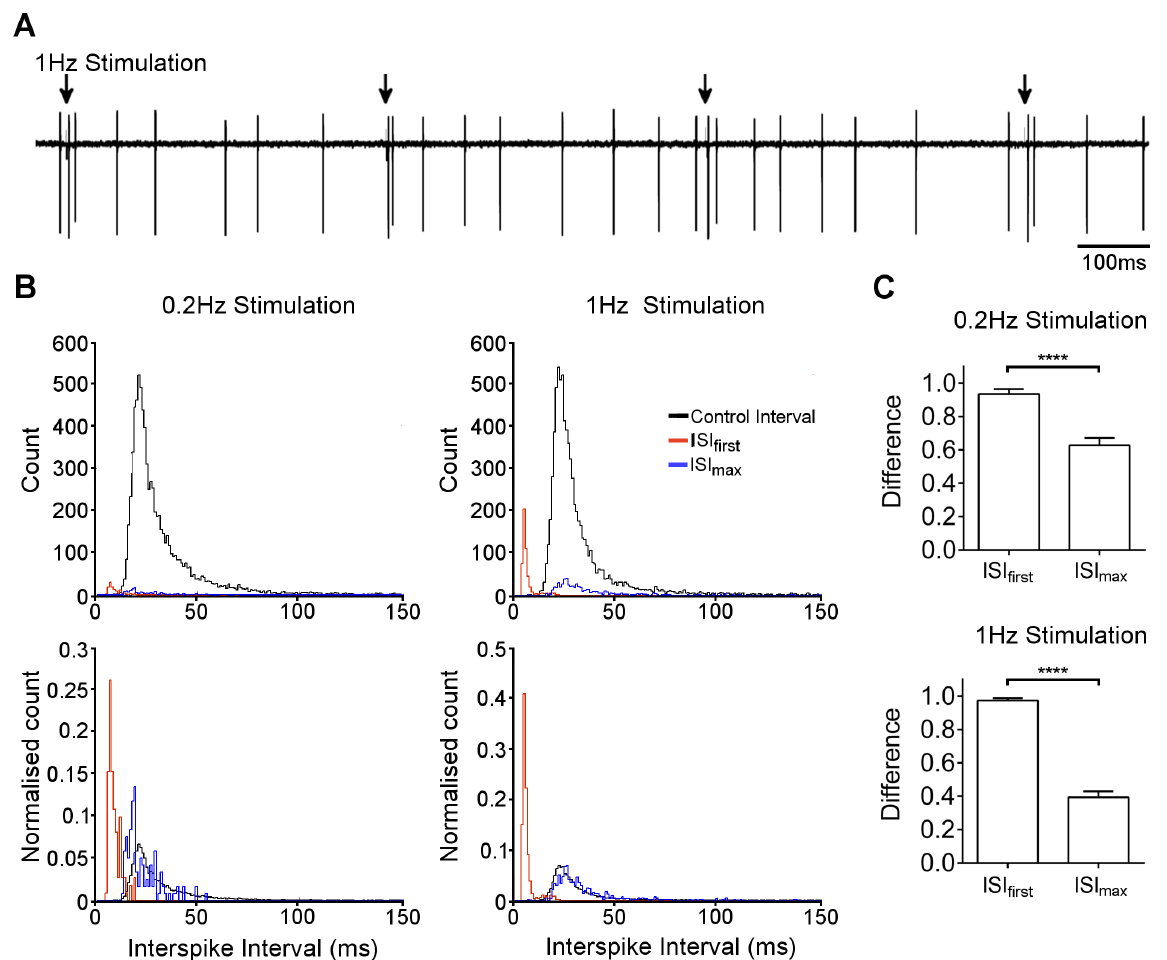
Figure 7. Distribution of post-stimulus intervals. A) Loose cell attached recording during regular stimulation at 1 Hz (arrow). B) Distribution of first post-stimulus interval (ISI first , red line), maximum post-stimulus interval (ISI max , blue line) and intervals uncorrelated with stimulus (black line). Left panels show representative cell stimulated at 0.2 Hz, right panels show representative cell stimulated at 1 Hz. Upper panels show total counts over 10 min, lower panels show populations normalised to AUC=1. C) Mean 6 s.e.m. difference between first interval (ISI first ) and maximum interval (ISI max ) using a distribution-difference metric (see Methods for details). ****p , 0.0001, unpaired t test.